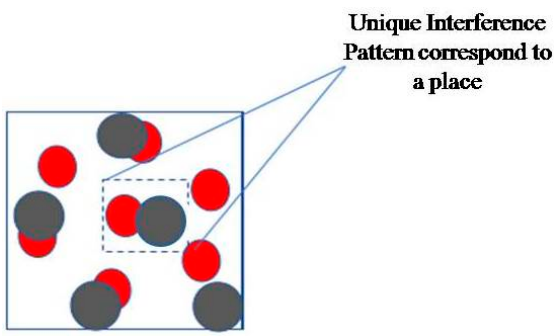
Appl. Sci. 2020 , 10 , x FOR PEER REVIEW Figure 4. Localization using overlapped grid patterns. Figure 4. Localization using overlapped grid patterns.